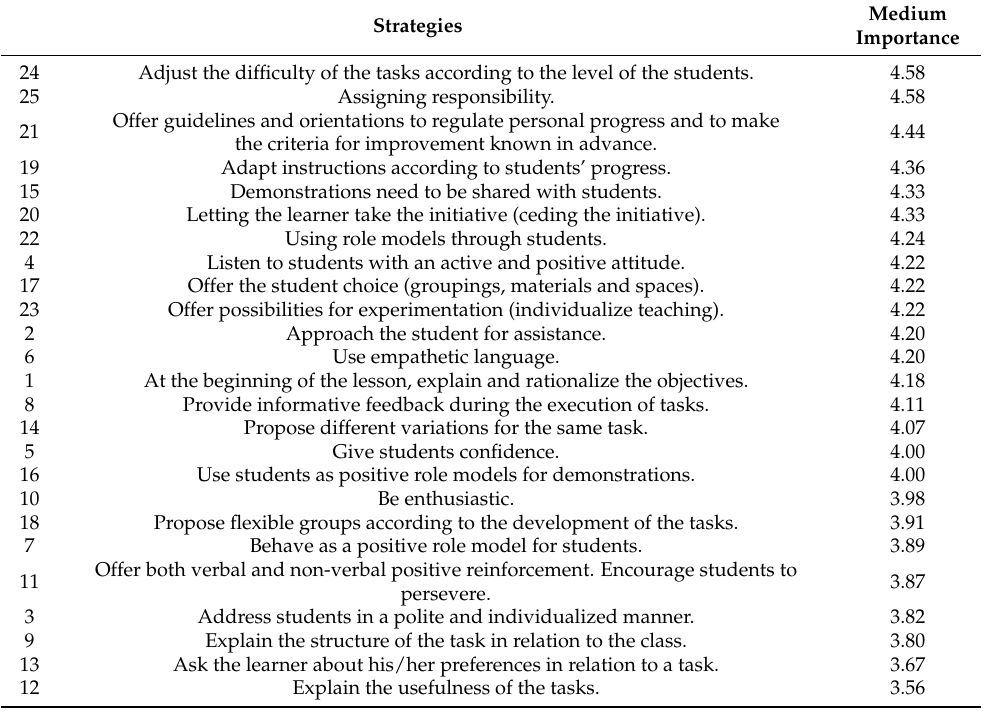
Table A6. Rating the importance of autonomy support strategies.